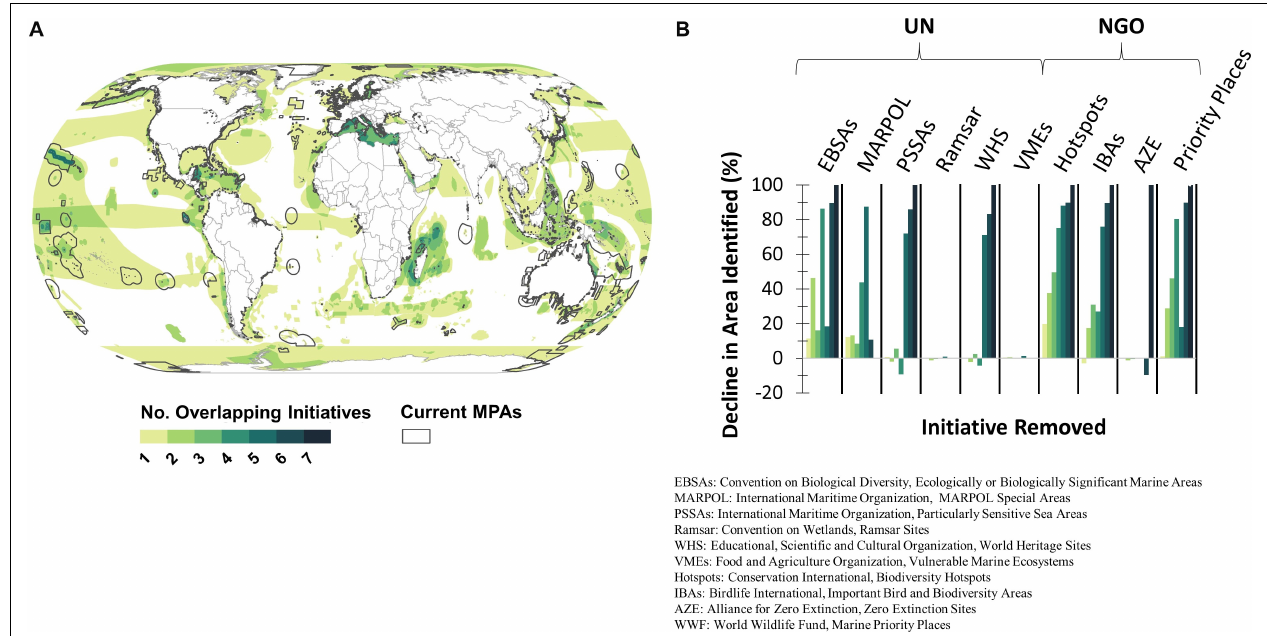
FIGURE 2 | Results of overlay analysis for marine areas identified as important by six United Nations and four non-governmental organization initiatives. The number of overlapping initiatives in each region is mapped in (A) and the impact of each initiative on the area identified at each level of overlap is shown in (B) . Initiatives identified 55% of the ocean as important, with up to seven initiatives overlapping. Overlap map (A) also shows current marine protected area coverage (World Database on Protected Areas, January 2019: UNEP-WCMC and IUCN, 2019a); most areas identified as important are not currently protected, except for areas identified by at least five initiatives (A) . Areas with overlap of at least two initiatives are concentrated in the Caribbean, the Mediterranean, the Coral Triangle, Madagascar and surrounding islands, and the Galápagos and surrounding islands (A) . The two initiatives with the largest impact on the area were Convention on Biological Diversity EBSAs and Conservation International Hotspots (B) . Countries are displayed using data provided by Natural Earth (Admin 0 Countries 4.1.0; Natural Earth,